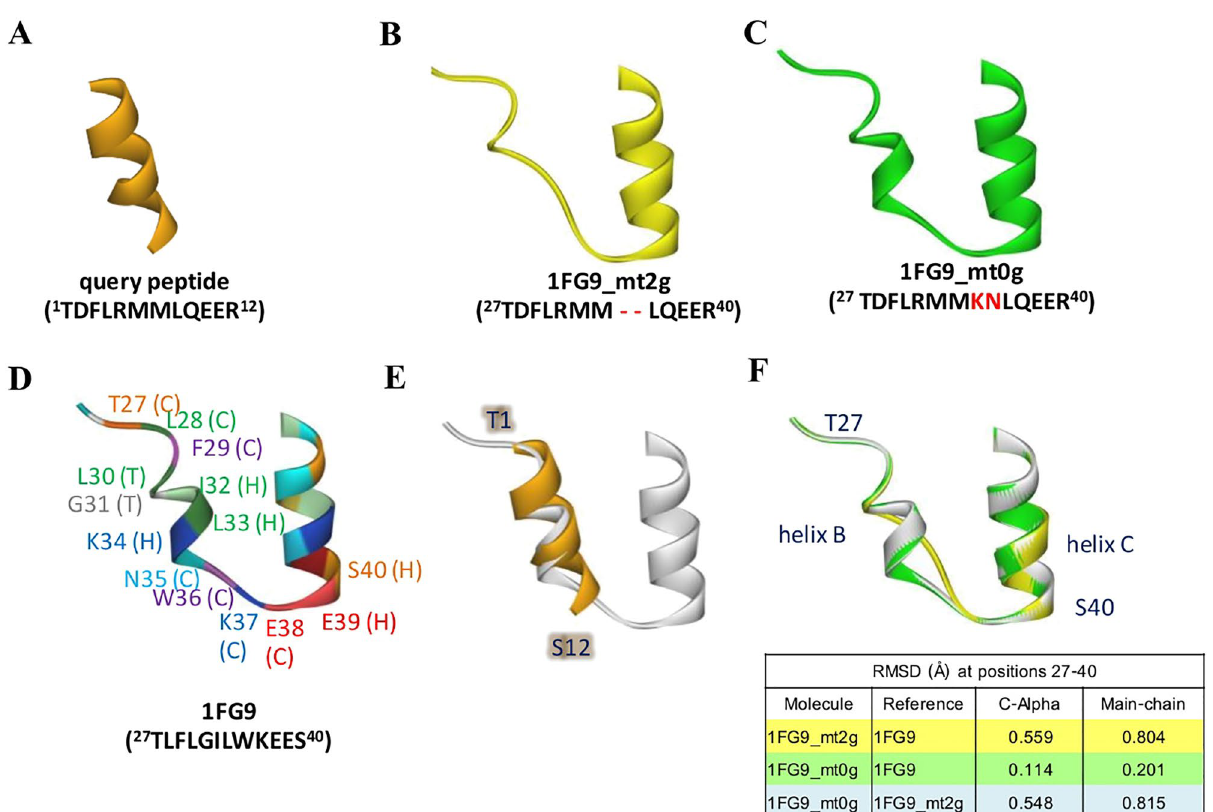
Figure 5. Predictive models of query. ( A ) The query peptide (orange), ( B ) 1FG9_mt2g (yellow), ( C ) 1FG9_ mt0g (green), ( D ) 1FG9, ( E ) superimposed structure of the peptide and 1FG9, and ( F ) superimposed